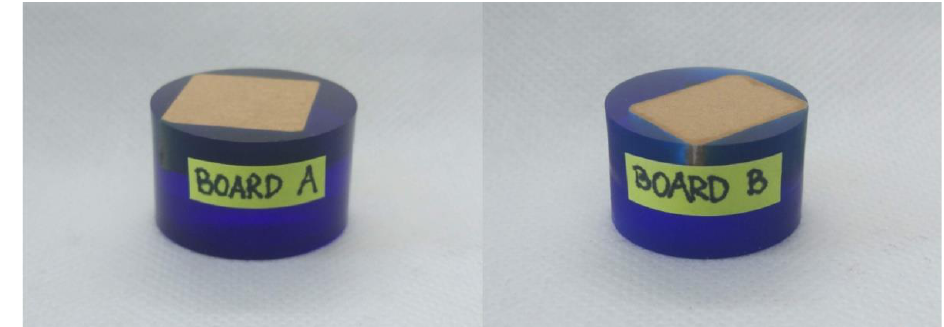
Figure 4. Samples prepared for the indentation.